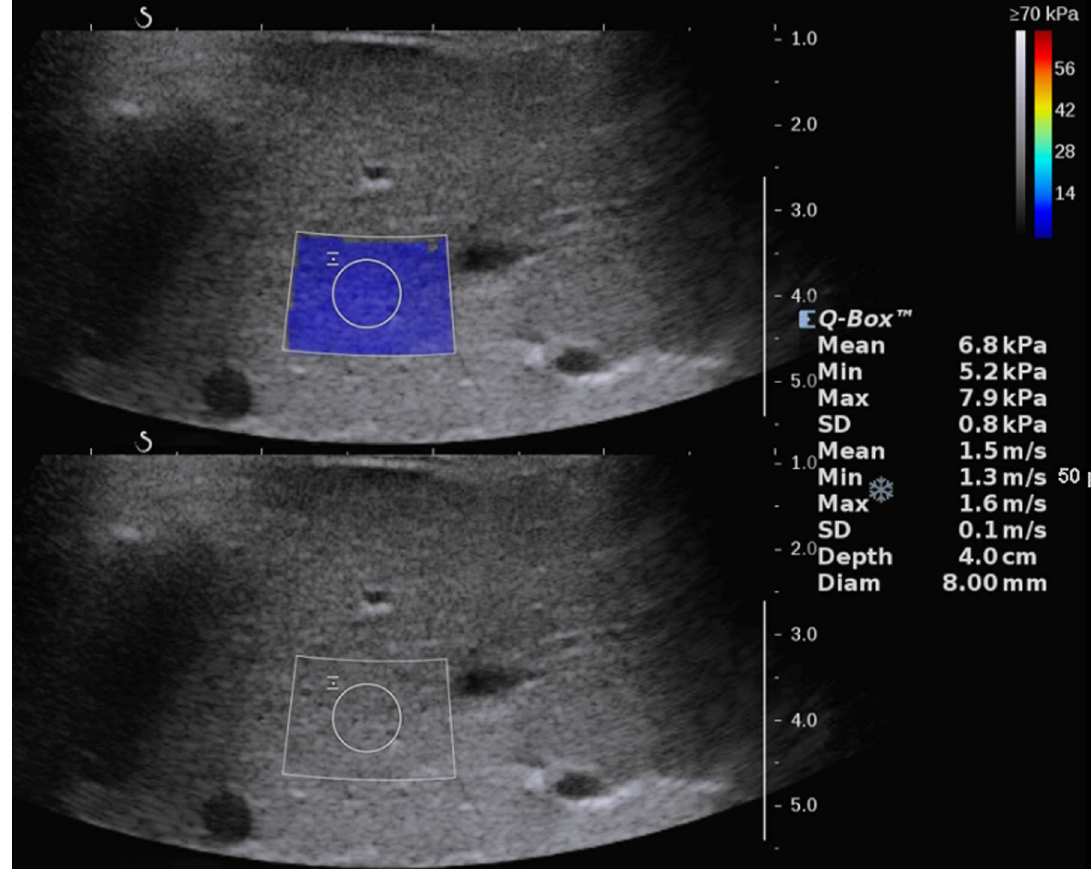
Fig 1. Ultrasound elastography image obtained from the liver of a 6-year-old girl. The circular regionof interest was placedon the color-coded map of homogeneous liver parenchymaat a location that avoidedvessels and bile ducts in the right lobe. The child was in the supineposition with free breathingstatus. Mean values were simultaneously providedfor both units of elasticityand velocity as 6.8 kPa and 1.5